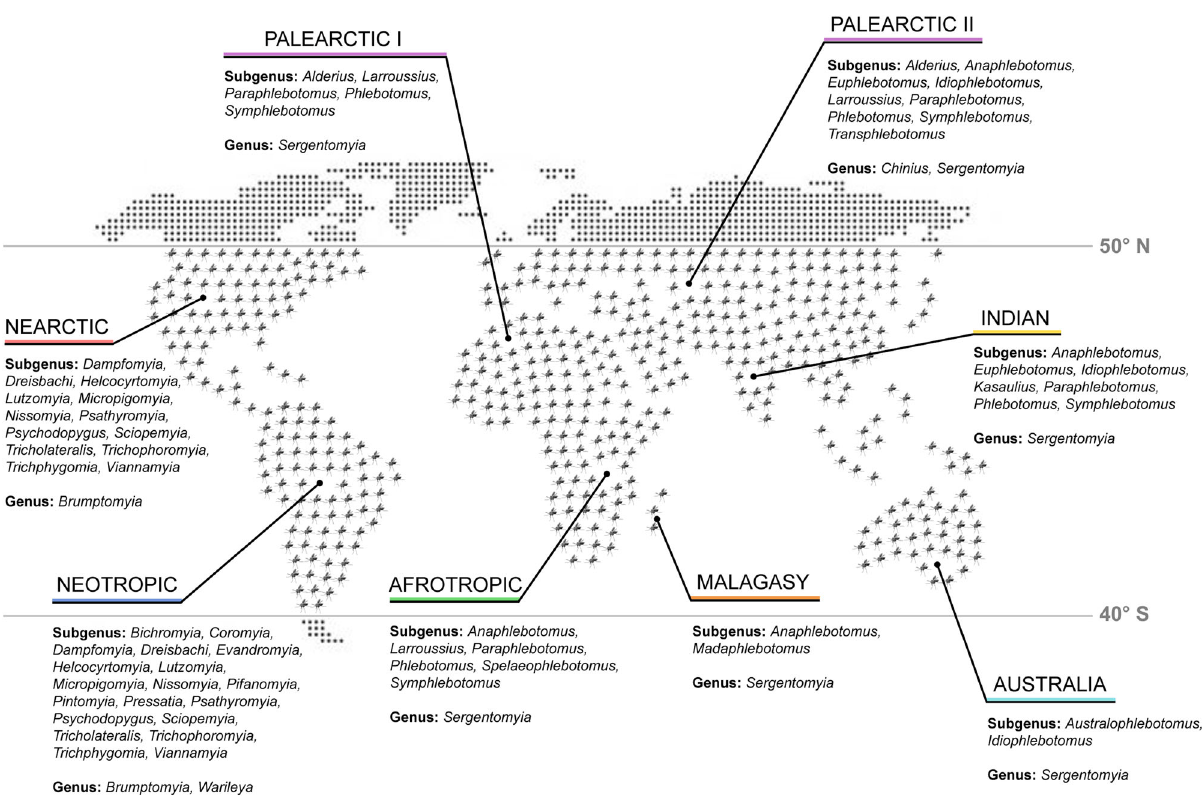
Fig. 1 Sand fl y distribution map by genera/subspecies. Sand fl ies have a global distribution between latitude 50° N and latitude 40° S (demarked by the gray horizontal lines), excluding New Zealand and the Paci fi c islands. In the map, the relevant sand fl y genera/subspecies (as per the widely accepted classi fi cation based on a conservative approach) are listed based on their presence in de fi ned zoogeographical regions: Palearctic (purple), Nearctic (red), Neotropic (dark blue), Afrotropic (green), Malagasy (orange), Australia (light blue), and Indian (yellow). Adapted from 7 . Courtesy